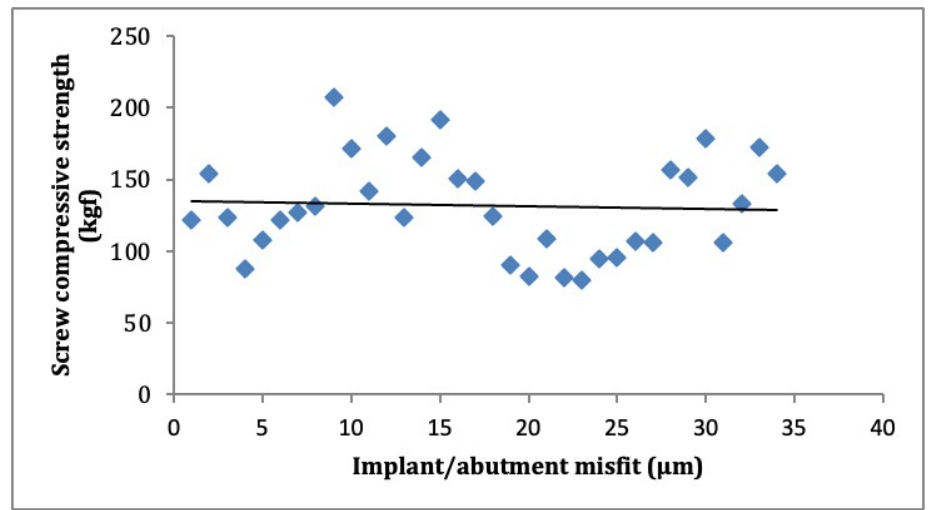
Figure 4. Dispersion diagram of implant/abutment misfit and compressive strength of connector screws. Table 3. Relative frequency (%) of failure modes observed in the implant/abutment according to the type of abutment and presence of mechanical